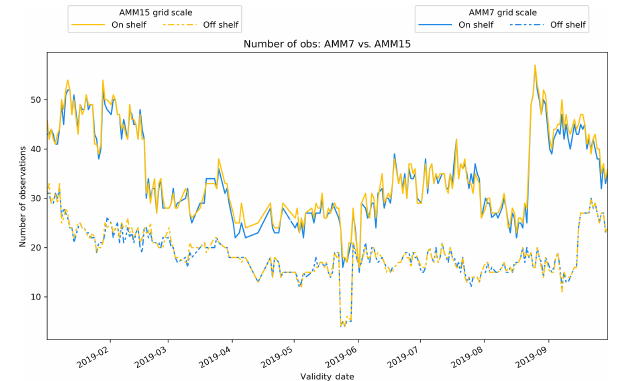
Figure 12. Monthly time series of whole-domain CRPS scores for the grid scale (solid line) and NB2 neighbourhood (dashes) for T + 60 forecasts. Error bars represent 95% confidence values obtained from 10000 samples using bootstrap with replacement. Error bars have been staggered in the x direction to aid clarity.